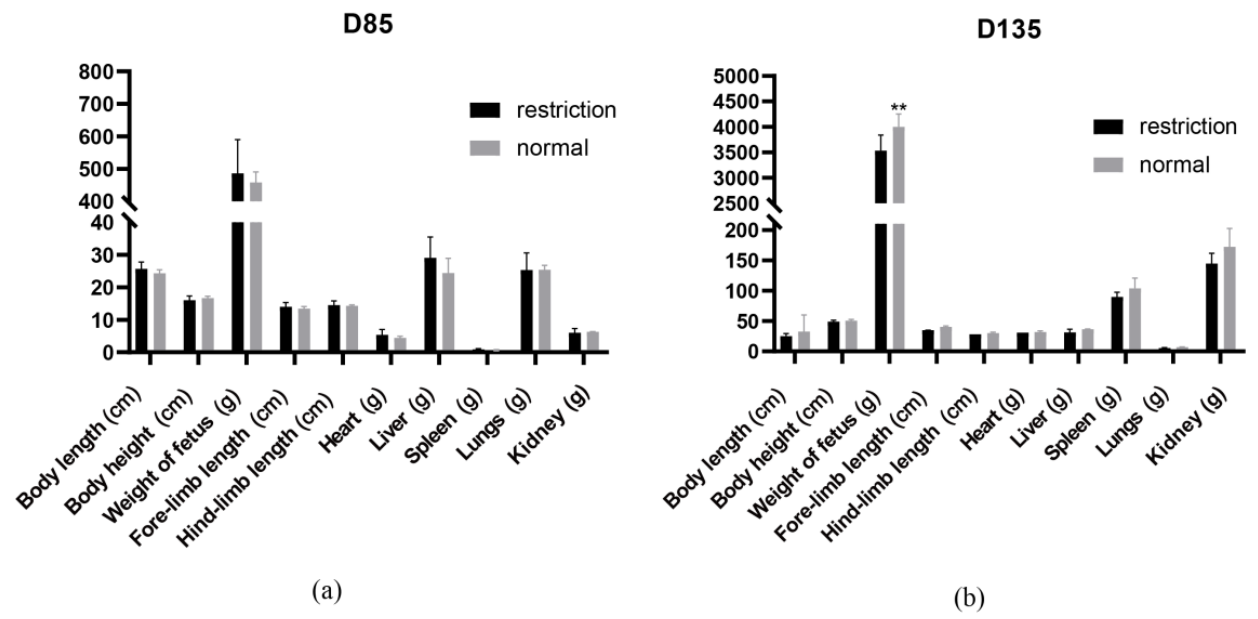
Figure 2. Phenotype analysis. Phenotype analysis of the fetal sheep at ( a ) GD 85 and ( b ) GD 135. The black box is the restricted maternal nutrition, the gray box is the normal maternal nutrition, and p < 0.01 (**) indicates an extremely significant difference.